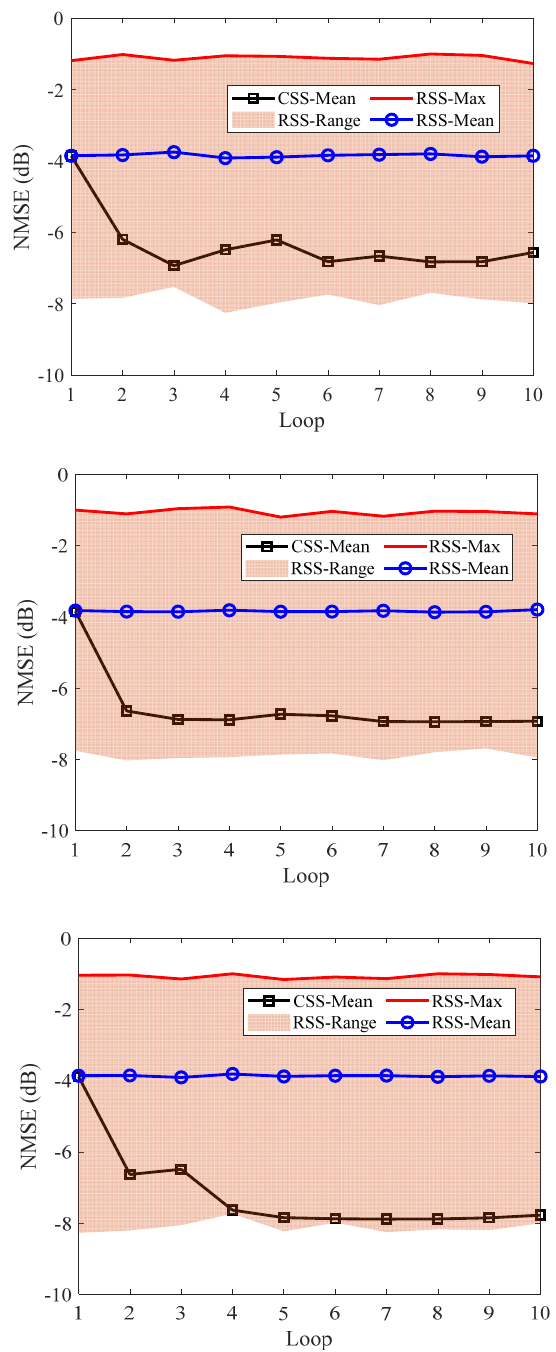
Figure 36. NMSEs of the real target images obtained by the proposed cognitive sparse imaging